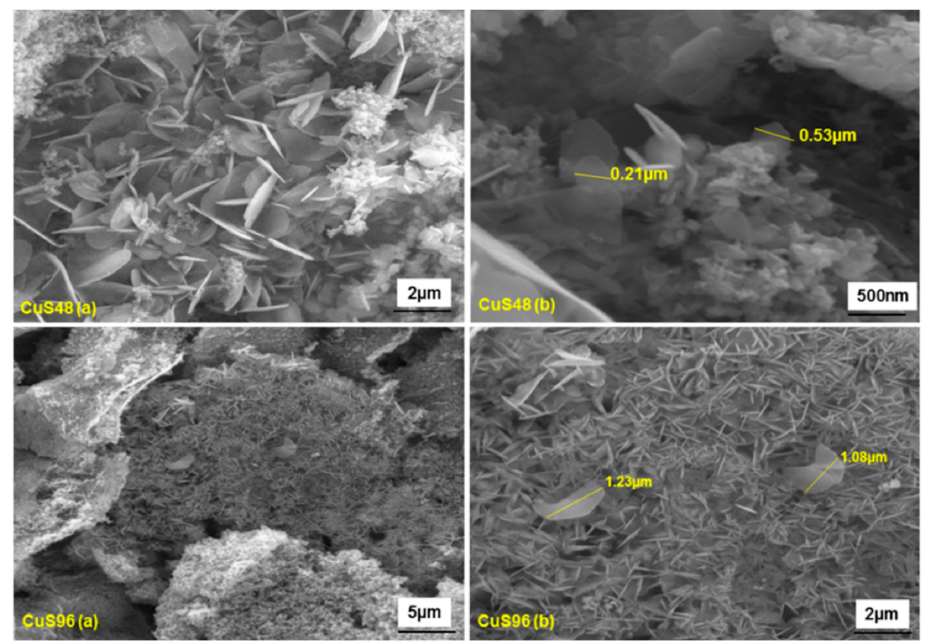
Figure 5. Scanning electrons microscopy (SEM) images of CuS48 and CuS96 samples with aggregate grains, placoid sheets, and hexagonal habit.